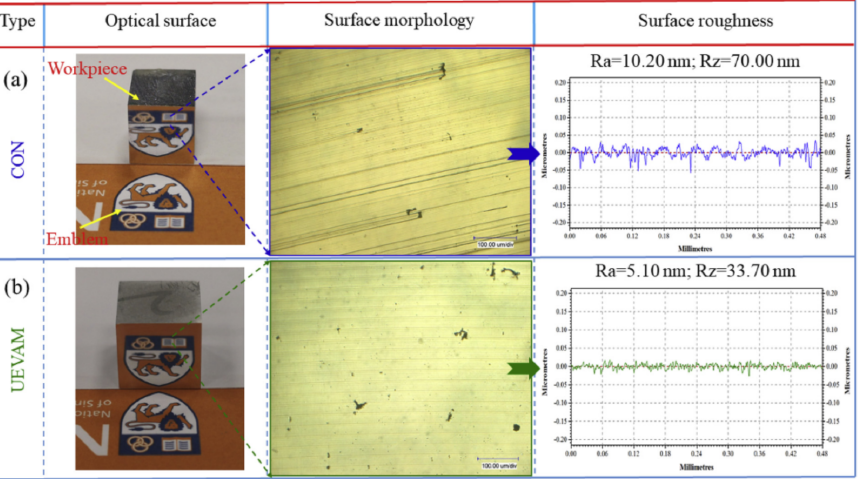
Figure 17. ( a ) Surface quality of SLM-ed AlSiMg0.75 alloy after conventional diamond turning. ( b ) ultrasonic elliptical vibration-assisted machining. (Reprinted with permission from ref. [61]. Copyright 2020,